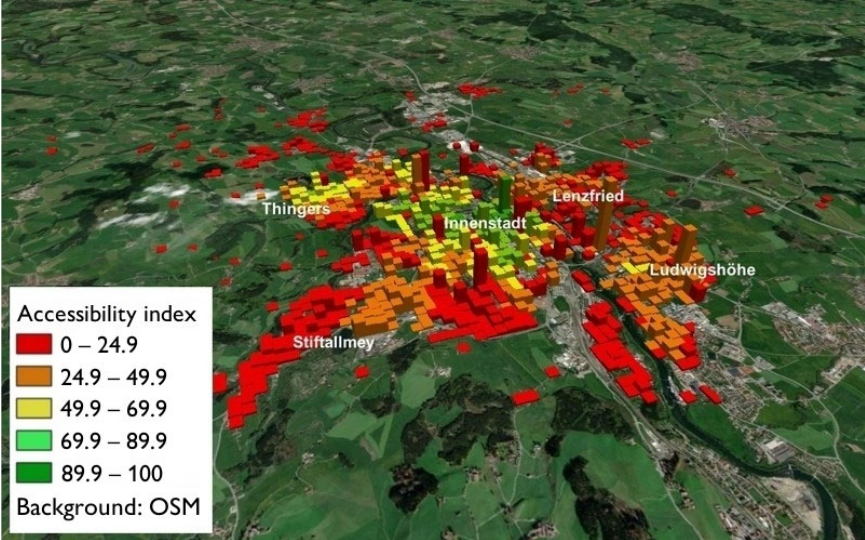
Figure 6. Walk Score and demographics in Kempten. Background map OpenStreetMap contributors.